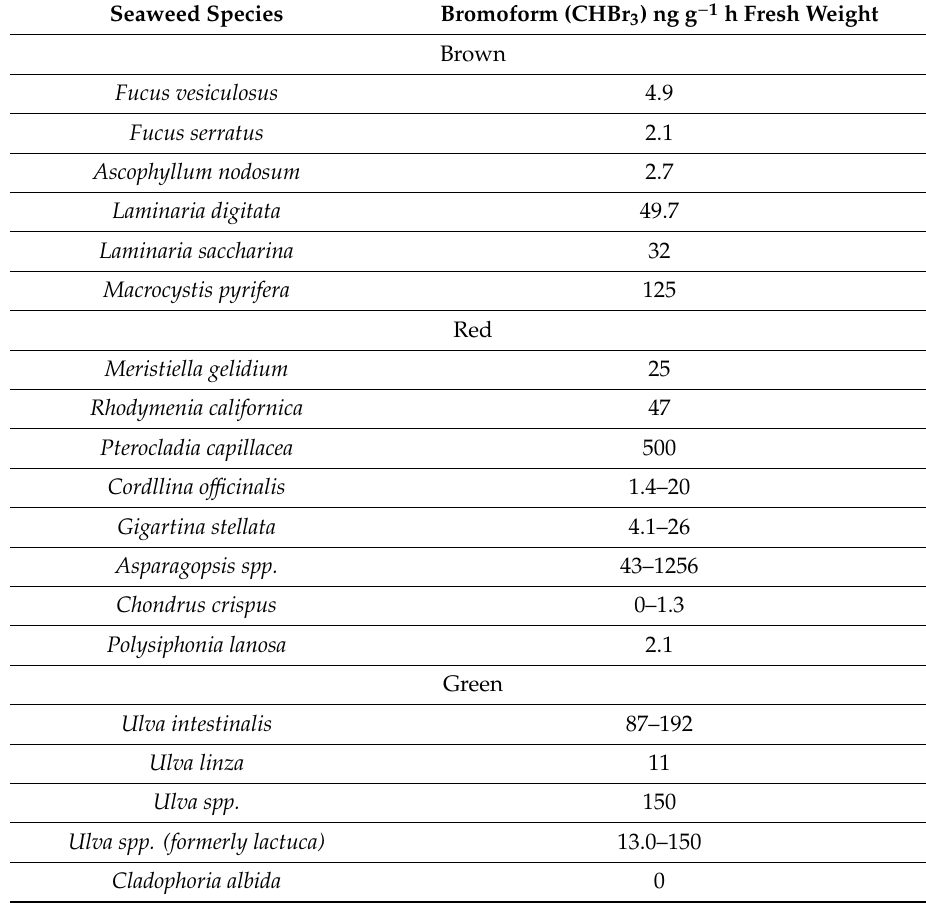
Table 3. Bromoform levels released from brown, red and green seaweeds per hour (adapted from Carpenter and Liss